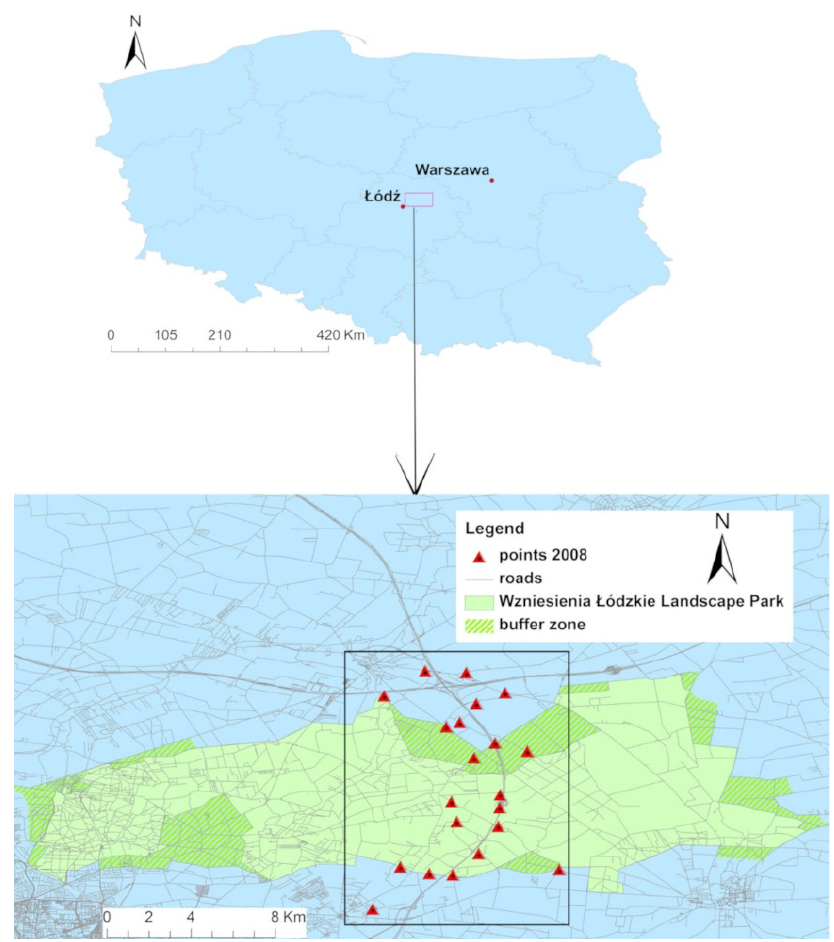
Figure 1. Location of PKW Ł .